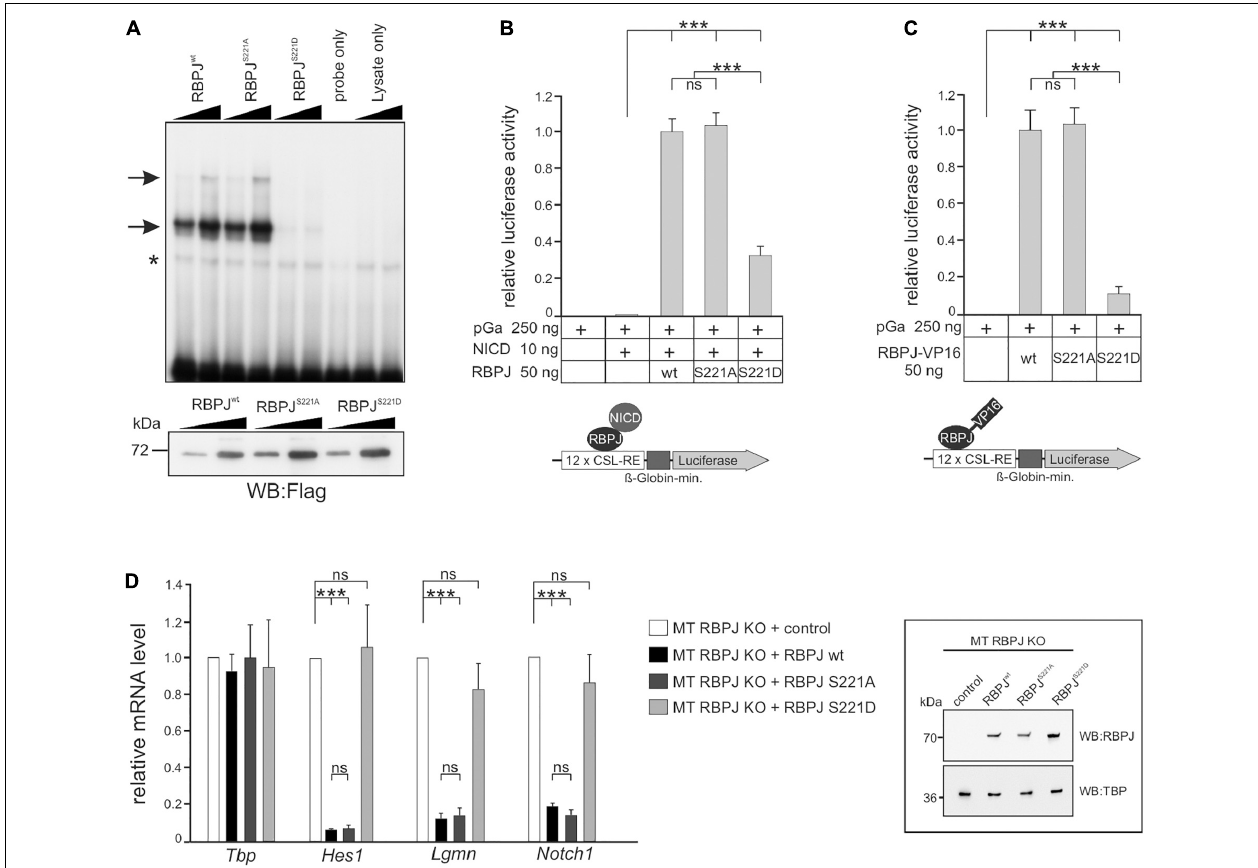
FIGURE 7 | RBPJ phospho-mutants impact Notch activity in vertebrate cells. (A) Electromobility shift assays (EMSA) using in vitro translated Flag-tagged RBPJ wt and RBPJ phospho-mutant proteins. Upper panel: DNA-binding complexes to an oligomeric duplex DNA probe with RBPJ binding sites are marked with arrows. The asterisk indicates unspecific background binding. Increasing amounts of TNT reticulocyte lysates (1 µ l and 2 µ l) were used as indicated. The double stranded oligonucleotides only and increasing amounts of reticulocyte lysates without in vitro transcription/translation reaction (lysates only) were used as controls. Lower panel: Relative abundance of in vitro translated Flag-tagged RBPJ fusion protein was tested by Western blotting using anti-Flag antibodies for detection. (B) Phospho-mimetic RBPJ S 221 D displays impaired transcriptional activity in Notch-dependent luciferase-reporter assays in HeLa cells lacking endogenous RBPJ . Cells were co-transfected with the indicated plasmids of RBPJ variant and human Notch 1 intracellular domain (NICD) together with the CSL-RE luciferase reporter (pGA981/6). (C) Activation of the luciferase reporter by the given RBPJ variant fused to the VP16 transactivation domain. Note that lack of RBPJ S 221 D activation is due to an impaired ability to bind to DNA. Luciferase activity is shown relative to activity of the reporter construct alone. Bars represent mean values from at least six independent experiments; error bars indicate standard deviation. (D) RBPJ phospho-mutant influences Notch target gene expression. Left panel: mouse hybridoma mature T-cells (MT) mutant for endogenous RBPJ , were used to re-introduce S221 RBPJ phospho-mutant variants as indicated, or empty vector (control). Total RNA was analyzed by qRT-PCR for the expression of the Notch target genes Hes1 , Lgmn , and Notch1 . Data shown represent the mean and standard of the mean of three independent experiments. Right panel: Western blots on MT cell nuclear extracts probed with an anti-RBPJ antibody. TATA-Box Binding Protein (TBP) was used as loading control. ANOVA two-tailed Tukey-Kramer test for multiple comparisons was applied for statistical analyses in panels (B–D) (*** p < 0.001; [ns] not